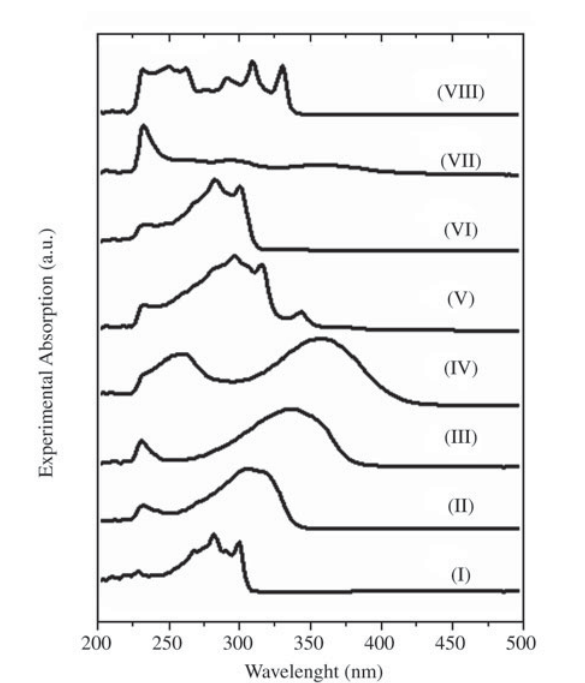
Figure 1 . Experimental UV-vis absorption spectra of alkynes I-VIII (Table 1) in CH